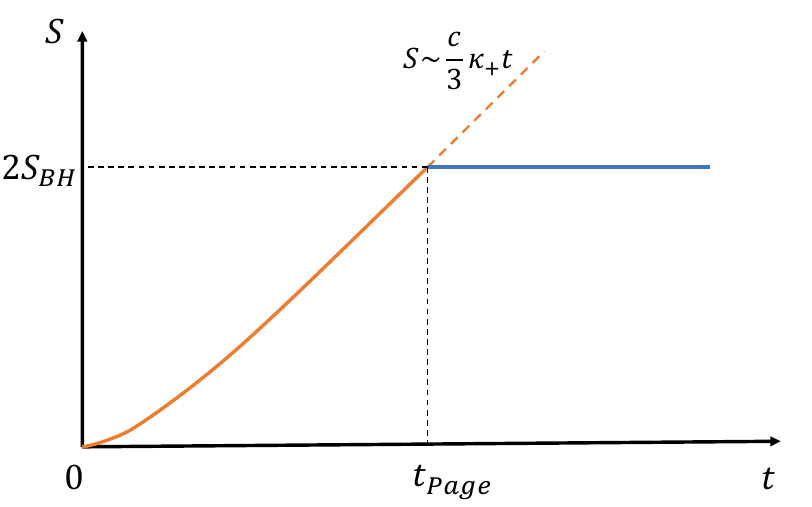
Figure 3 . The Page curve for the eternal Reissner-Nordström black hole with the assumption that the higher order terms in c G N /r 2 are ignored. The orange dashed line shows the result without h islands. The solid line represents the quantitative result with